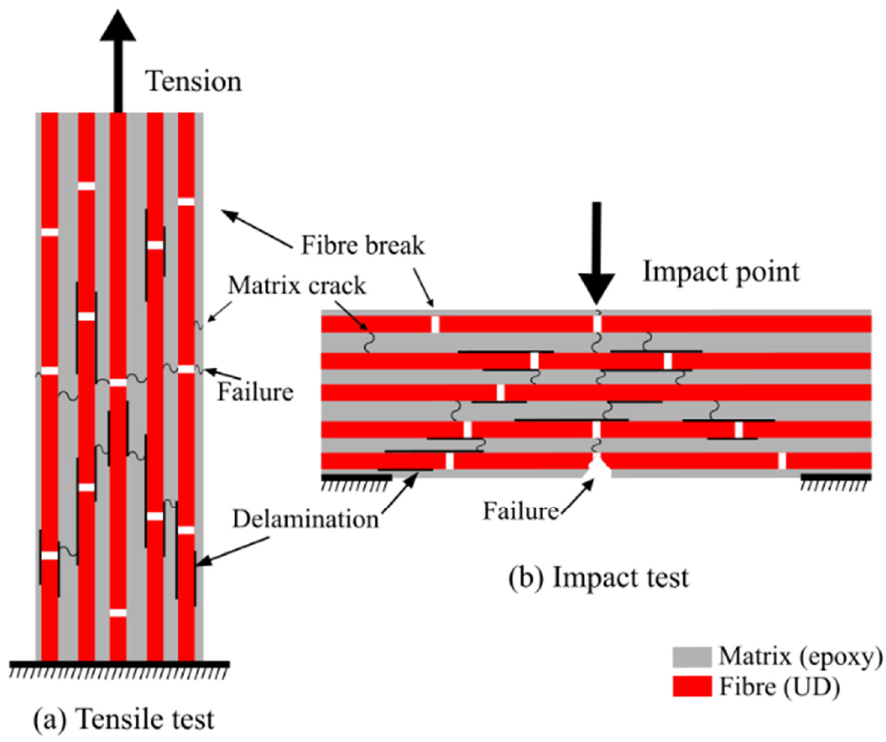
Figure 1. Damage sequence of UD FRP composites tensile mode (modified from [35]) and impact mode (modified from [39]).